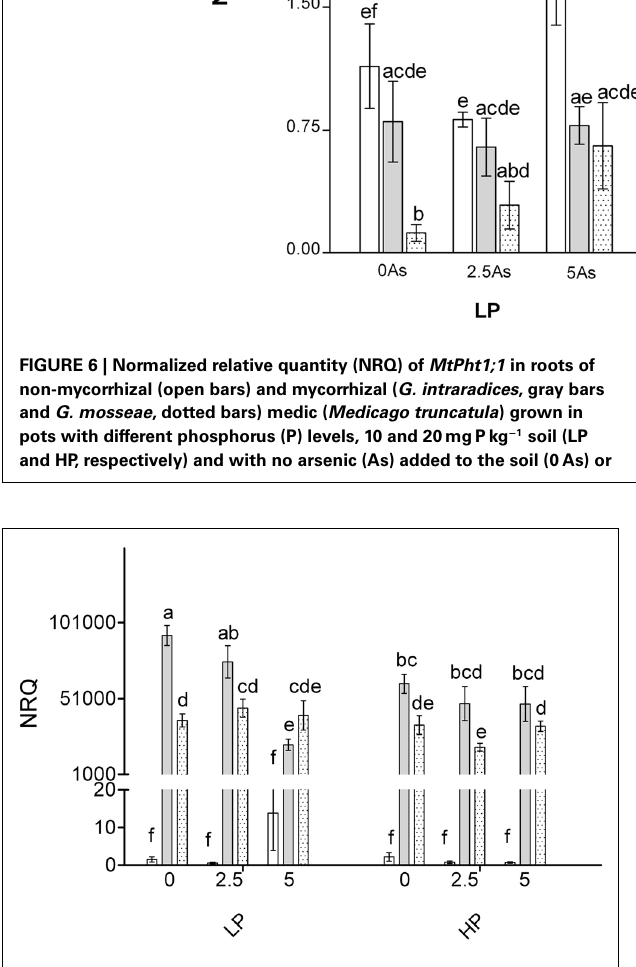
FIGURE 7 | Normalized relative quantity (NRQ) of MtPht1;4 in roots of non-mycorrhizal (open bars) and mycorrhizal ( G. intraradices , gray bars and G. mosseae , dotted bars) medic ( Medicago truncatula ) grown in pots with different phosphorus (P) levels, 10 and 20mgPkg − 1 soil (LP and HP, respectively) and with no arsenic (As) added to the soil (0As) or at rates of 2.5 and 5mgAskg − 1 soil (2.5As and 5As, respectively). Data are presented as mean values ± SEM ( n = 5, except for treatment group NM, HP5As where n = 3).The interaction between all factors (P, As, and inoculation) was significant ( P = 0.002). Same letters indicate no significant difference between treatment groups at the 5% level.